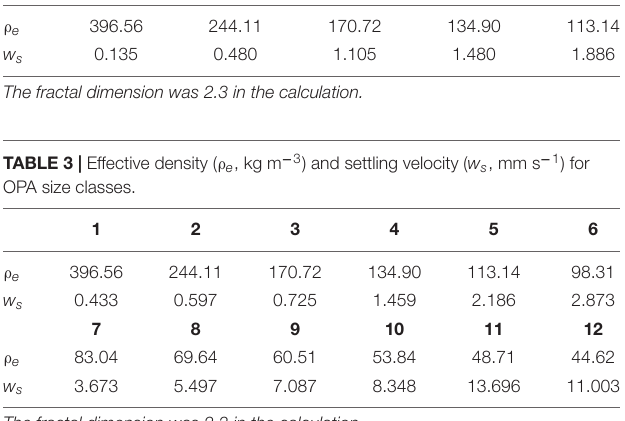
Frontiers in Marine Science |